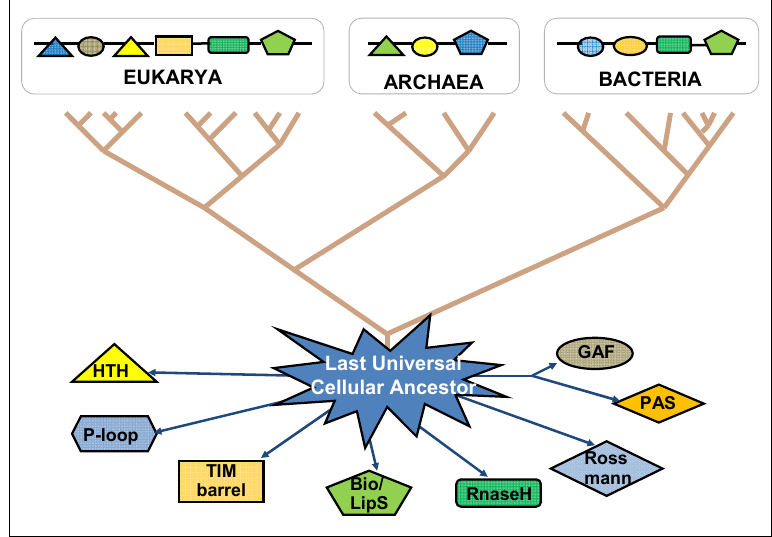
Figure 2. The “big bang” of protein universe. Some of the fundamental domains related to the Last Universal Cellular Ancestor (LUCA, possibly a RNA-centered organism with DNA intermediate in replication) are represented at the bottom. After their evolution by modification and recombination they reappear in more complex proteins of extant life forms; those found in eukaryotes being of particular complexity. (Modified from